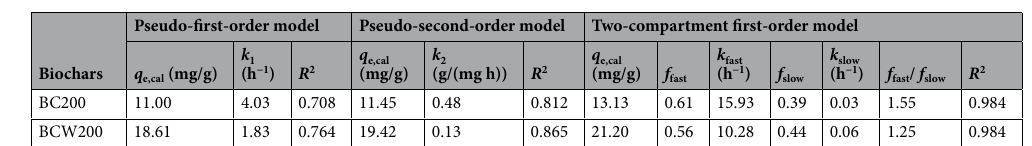
Table 2. The fitting results of the pseudo-first-order model, pseudo-second-order model and two- compartment first-order model.